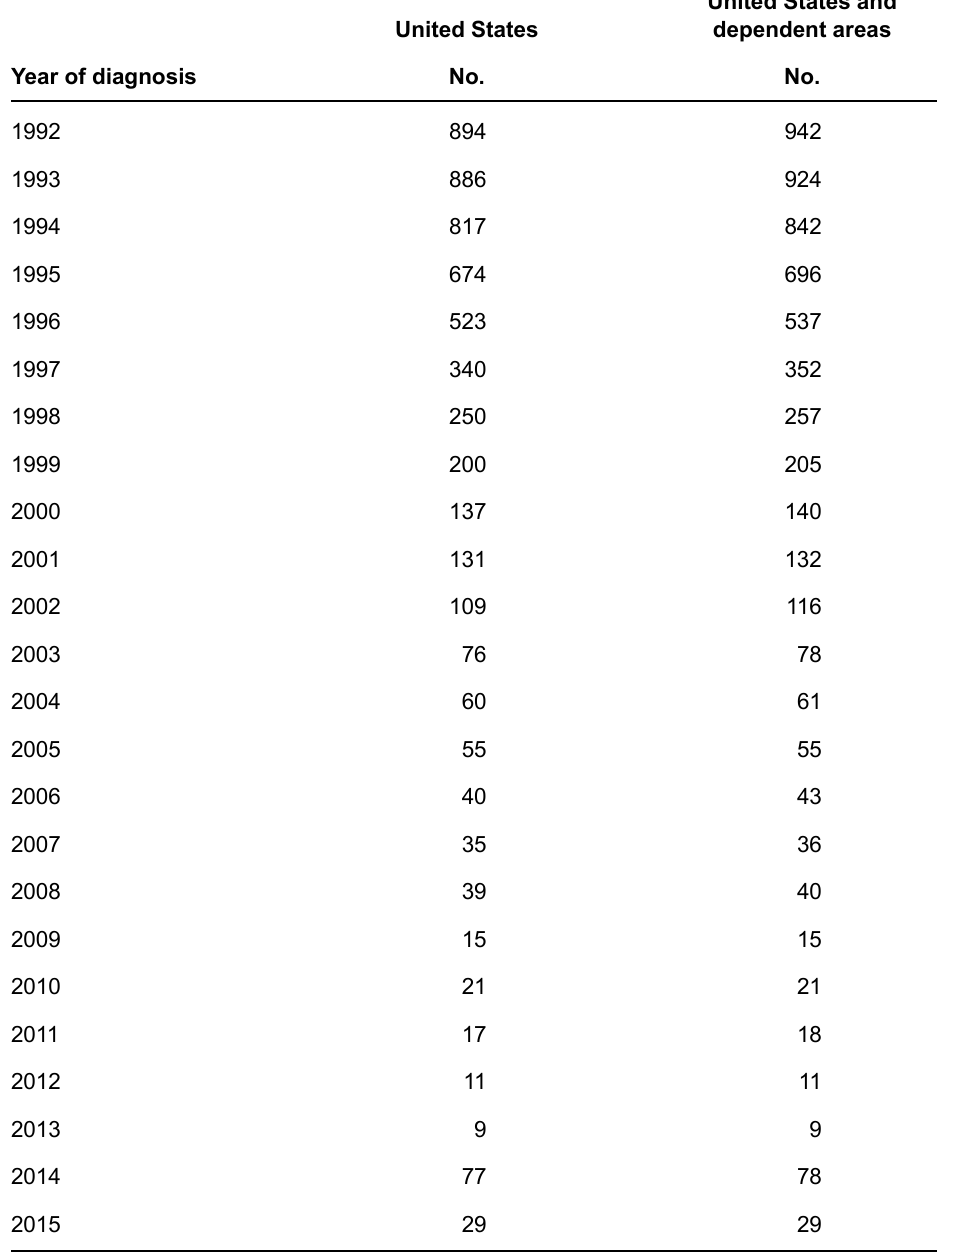
Table 9. Stage 3 (AIDS) among children aged <13 years, by year of diagnosis, 1992–2015—United States and 6 dependent areas United States and United States dependent